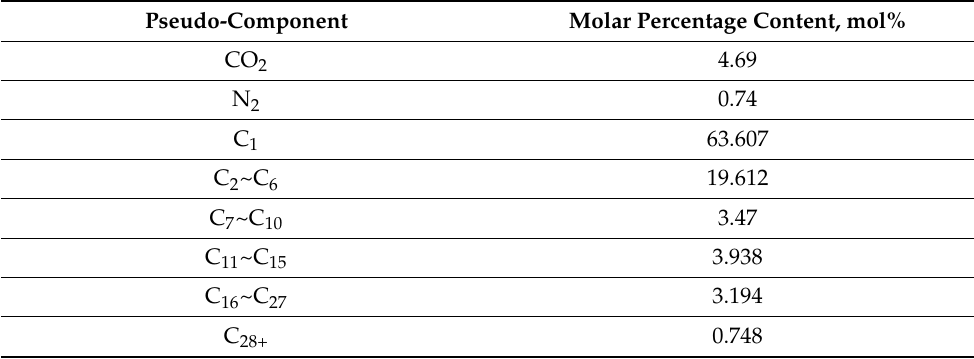
Table 3. Pseudo-component division of well stream composition for X well.